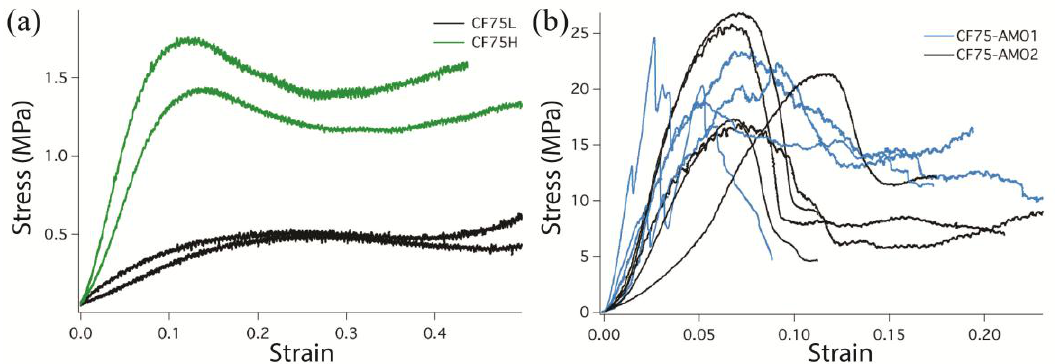
Figure 2. Unaxial compression stress-strain curves for the HTPB binder formulations CF75L and CF75H ( a ) and the CF75-AMO formulations ( b ). Note the different scales—the HTPB samples in ( a ) are more compliant. Compression tests were performed at ambient temperature and a strain rate of 0.0045